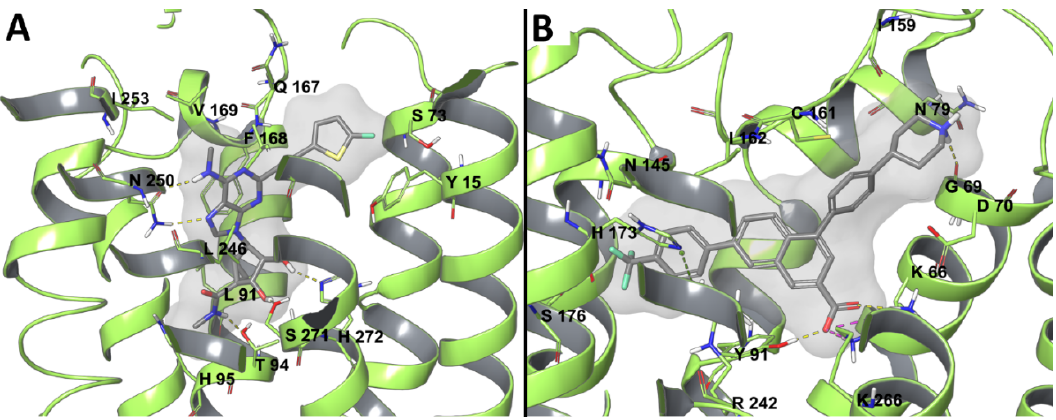
Figure 3. ( A ) Docking pose of MRS7334 (gray) [74] at an A 3 AR model (light green) [69]. ( B ) Docking pose of PPTN (gray) at a P2Y 14 R model (light green) [78].